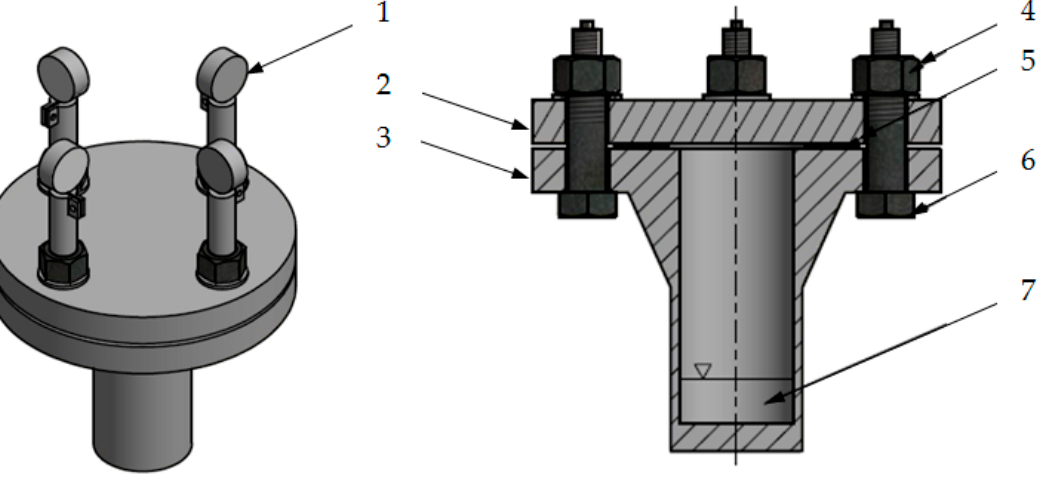
Figure 1. Scheme of the test stand: 1—dial gauge, 2—upper flange, 3—lower flange, 4—nut, 5—gasket, 6—bolt, 7—20 mL chamber with fuel.